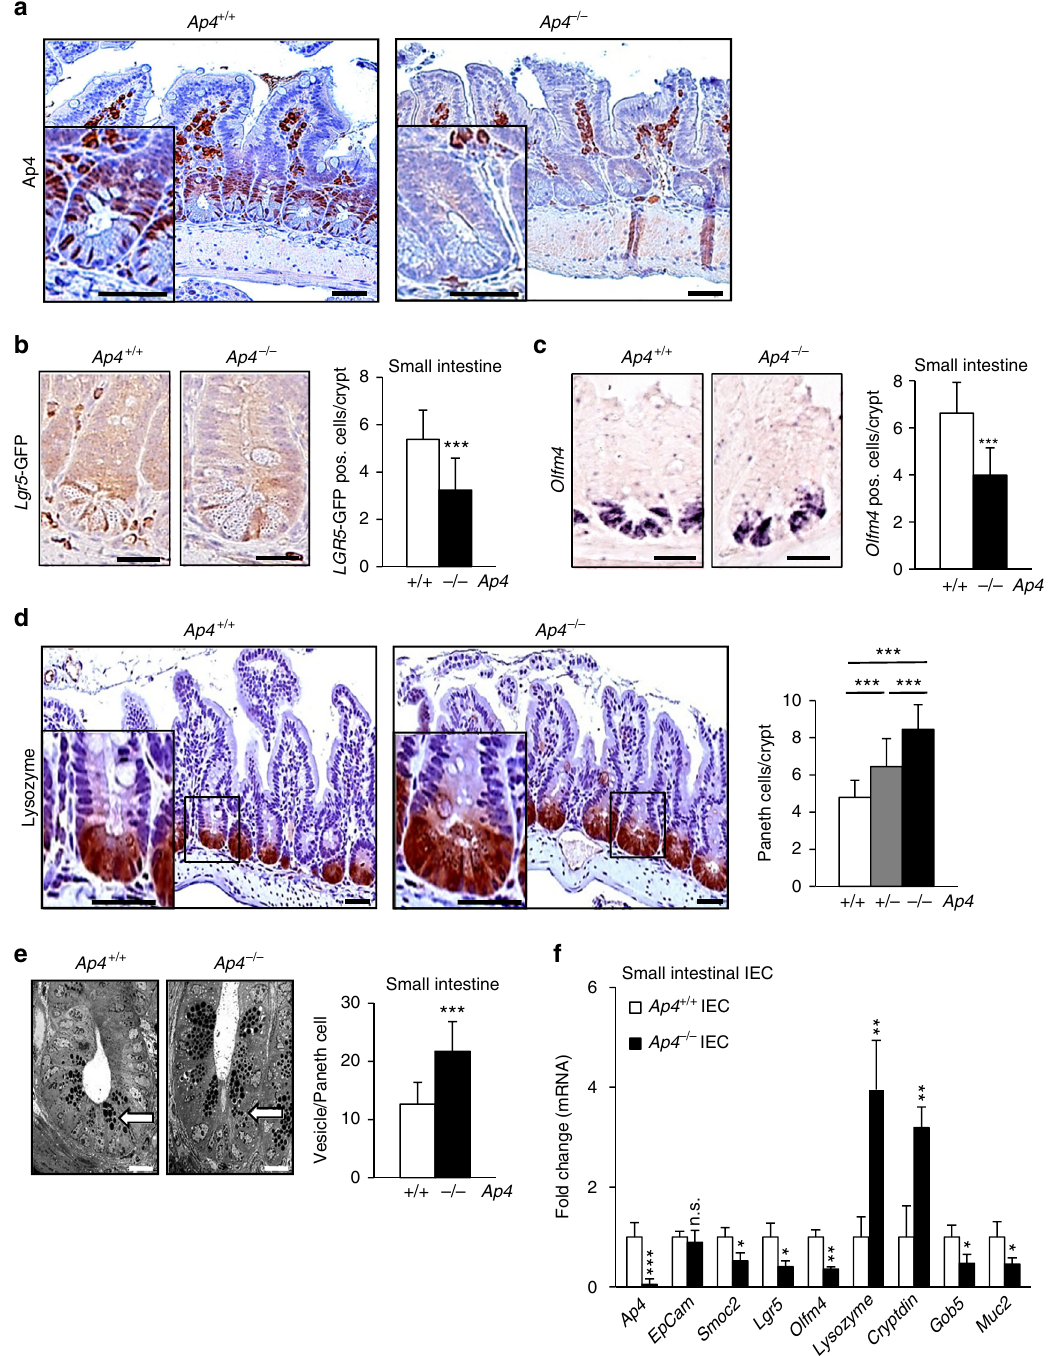
Fig. 6 Inactivation of Ap4 causes decrease of ISC and increase Paneth cell numbers. a Immunohistochemical detection of Ap4 (brown) in small intestinal tissue, ileum of one male and one female mouse per genotype. Scale bar = 50 µ m (25 µ m insert), white arrow: site of speci fi c Ap4 expression. Mast cells in the villi display an unspeci fi c staining. Counterstaining with hematoxylin. b Left panel: immunohistochemical analyses of Lgr5-eGFP in intestinal sections of 63 days old Lgr5-eGFP mice. Scale bars represent 25 µ m. Right panel: quanti fi cation of Lgr5-eGFP-positive cells in the crypt base of the ileum from two male and two female mice (130 crypts) per genotype. c Left panel: in situ hybridization of Olfm4 mRNA. Scale bars represent 25 µ m. Right panel: quanti fi cation of Olfm4-positive cells in the crypt base from two male and two female mice (316 crypts) per genotype. d Left: immunohistochemical detection of Lysozyme (brown) expressed in Paneth cells. Counterstaining with hematoxylin. Scale bar: 50 µ m (25 µ m insert). Right: the small intestine/ ileum from two male and two female mice (100 crypts) per genotype was analyzed for Paneth cells/crypt. e Electron microscopic analysis of small intestinal crypt base; white arrow: Paneth cells. Scale bar: 25 µ m. f qPCR analysis of the indicated mRNAs in IECs of the ileum of two male and one female mice per genotype. b , c , d , e , f Results represent the mean ± SD. Results were subjected to an unpaired, two-tailed Student ’ s t -test with p -values * < 0.05, ** < 0.01, *** < 0.001, n.s.: not signi fi cant. See also Supplementary Figs. 5, 6,